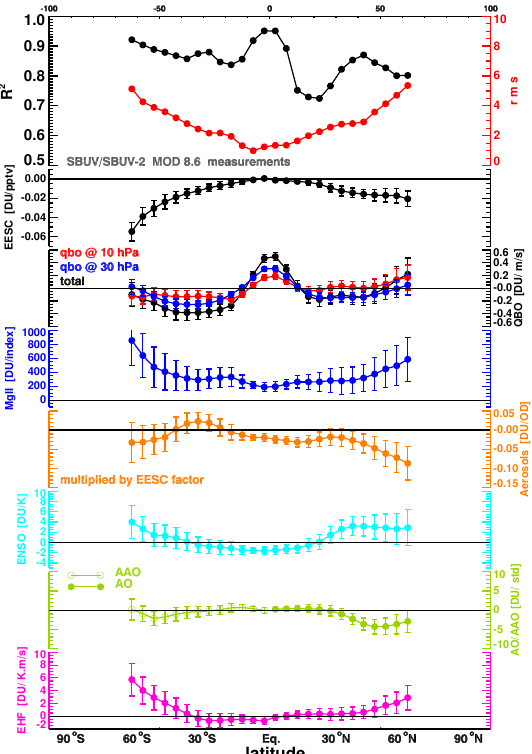
Figure 3. Annual mean total ozone variations for 60–65 ◦ N in DU (SBUV/SBUV-2 Version 8.6 data set from 1979–2012) and magni- tude of contributing factors obtained by multiple linear regressions. Top panel: observed total annual mean data (red), corresponding fit (blue) and the EESC curve (black). Green line marks the resid- uals between the observed ozone and regressed time series (sec- ond panel). Bottom panels show the contributions from: QBO at 10hPa, (red), at 30hPa (blue) and combined effect (black), blue: 11-year solar cycle (MgII index); orange: enhanced stratospheric aerosols; turquoise: ENSO (3.4) index, eddy heat flux in magenta and AO/AAO oscillation in lime-green, respectively. The coefficient of determination ( R 2 ) between the observed and regressed ozone and root mean square (rms) are indicated in the first panel. The re- gression coefficients of various proxies along with the 1- σ standard deviation (in brackets) are also indicated in each panel.